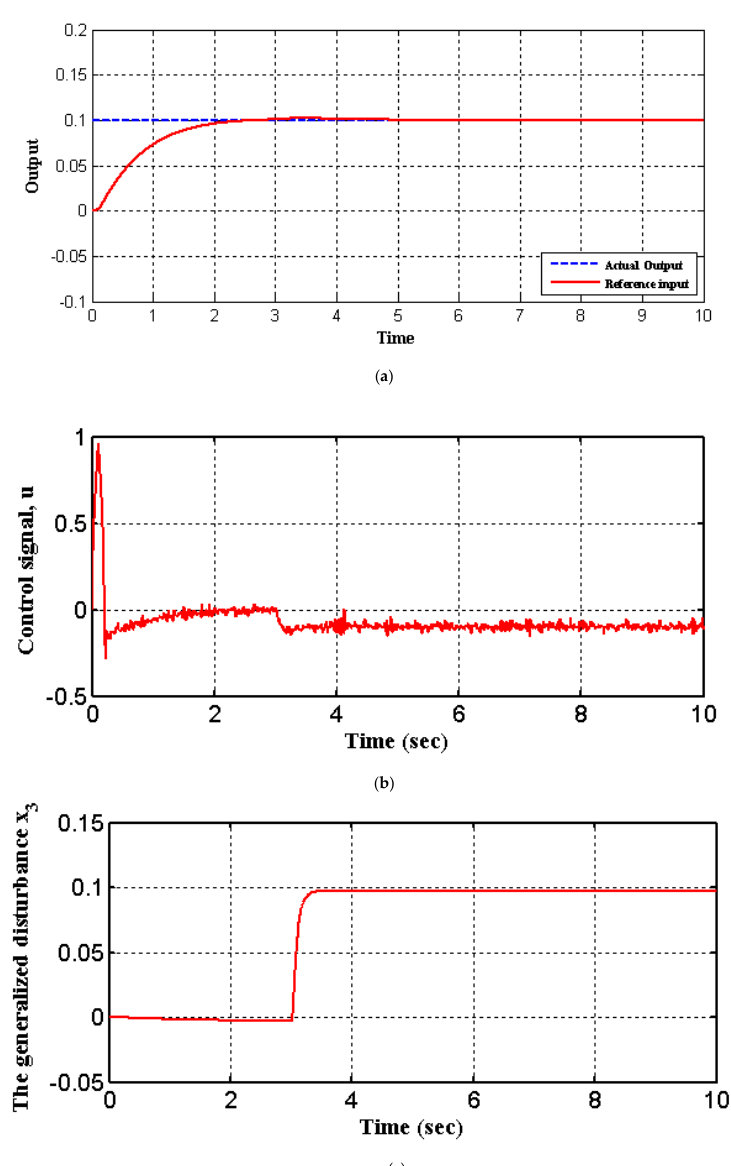
Figure 15. The result for the mass spring dumper model using N-ADRC, ( a ) output (y), ( b ) control signal, ( c ) the generalized disturbance. The numerical results are listed in Table 3 . Adding an extra LESO to the C-ADRC significantly affected the output response (ITAE) of the N-ADRC controller. In Table 3, ITAE = (cid:1516) (cid:1872)|(cid:1877) − (cid:1870)|(cid:1856)(cid:1872) (cid:2870)(cid:2868) (cid:2868) is the integration of the time absolute error for the output signal, and ISU = (cid:1516) (cid:1873) (cid:2870) (cid:1856)(cid:1872) (cid:2870)(cid:2868) (cid:2868) of the square of the control signal. Table 3. Performance indices. Controller